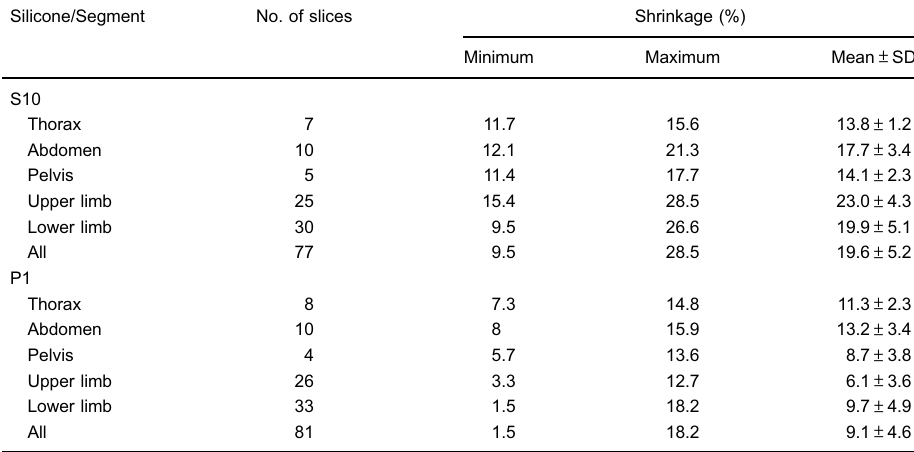
Table 1. Maximum, minimum, and mean ± SD percent shrinkage in pieces according to anatomical segments and silicones used (S10 or P1). Silicone/Segment No. of slices